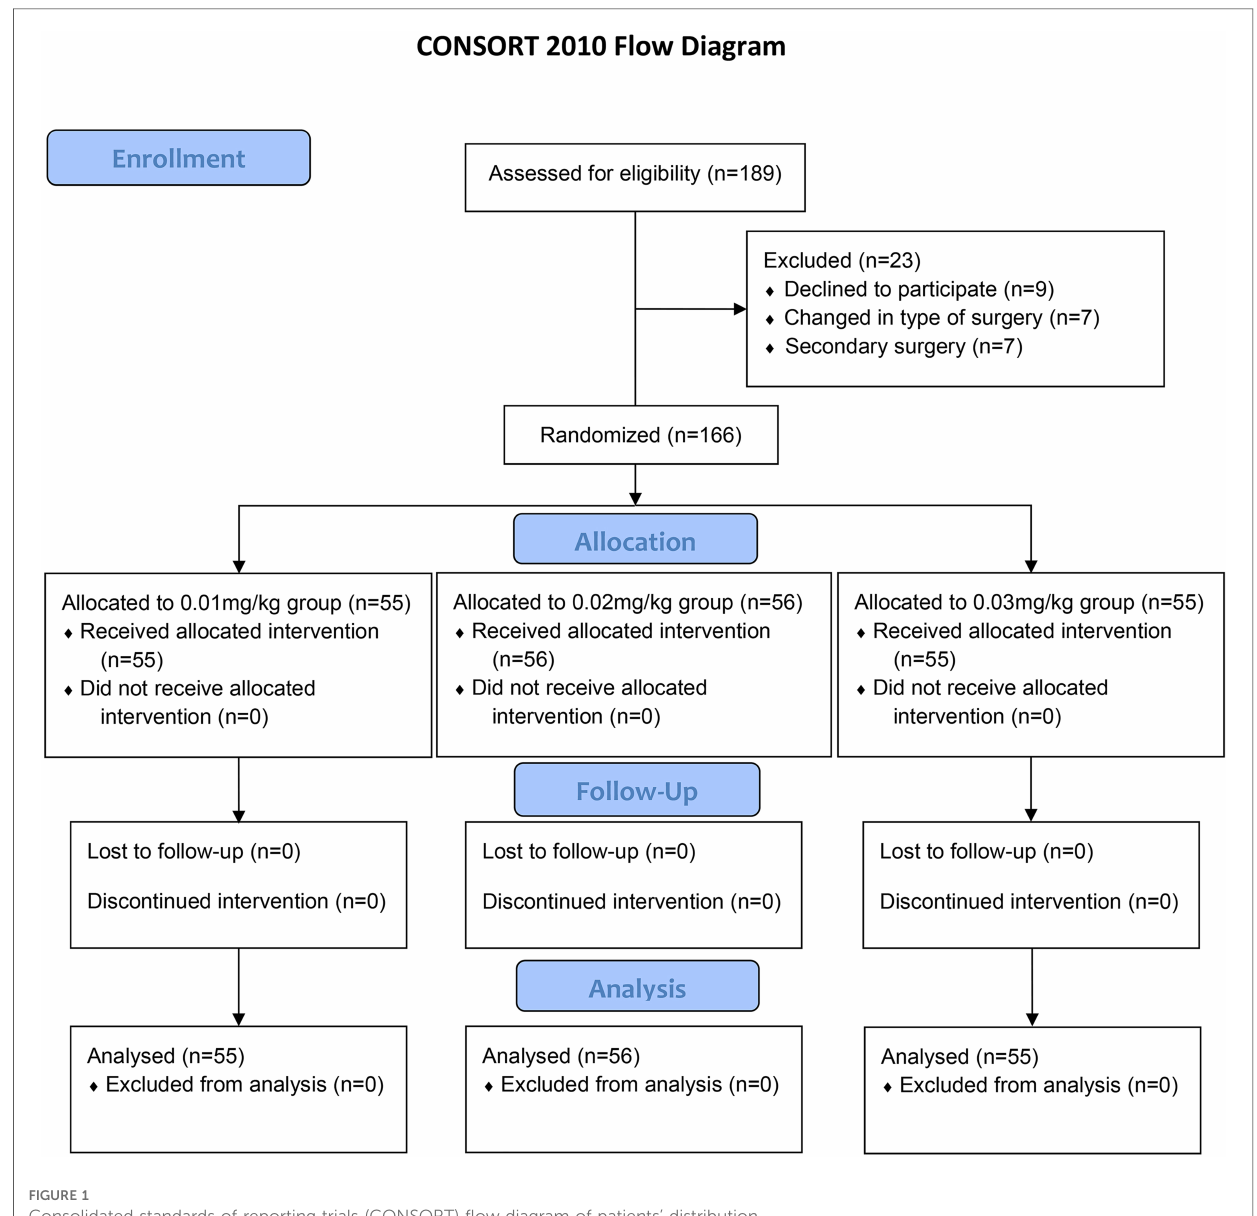
FIGURE 1 Consolidated standards of reporting trials (CONSORT) fl ow diagram of patients ’